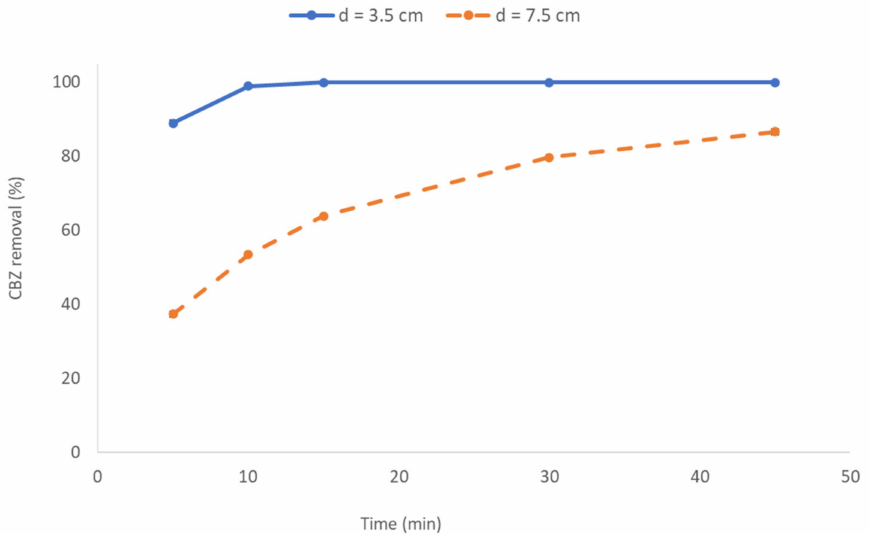
Figure 2. Effect of interelectrode distance on the removal of CBZ from aqueous solutions (operational conditions: j = 6.67 mA/cm 2 ; NaCl = 0.1 M; CBZi = 10 mg/L; pH = 5; reaction time = 45 min; cathode = STS; anode = MMO).